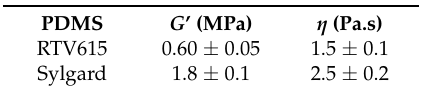
Table 1. Values of storage modulus and viscosity for two kinds of PDMS.